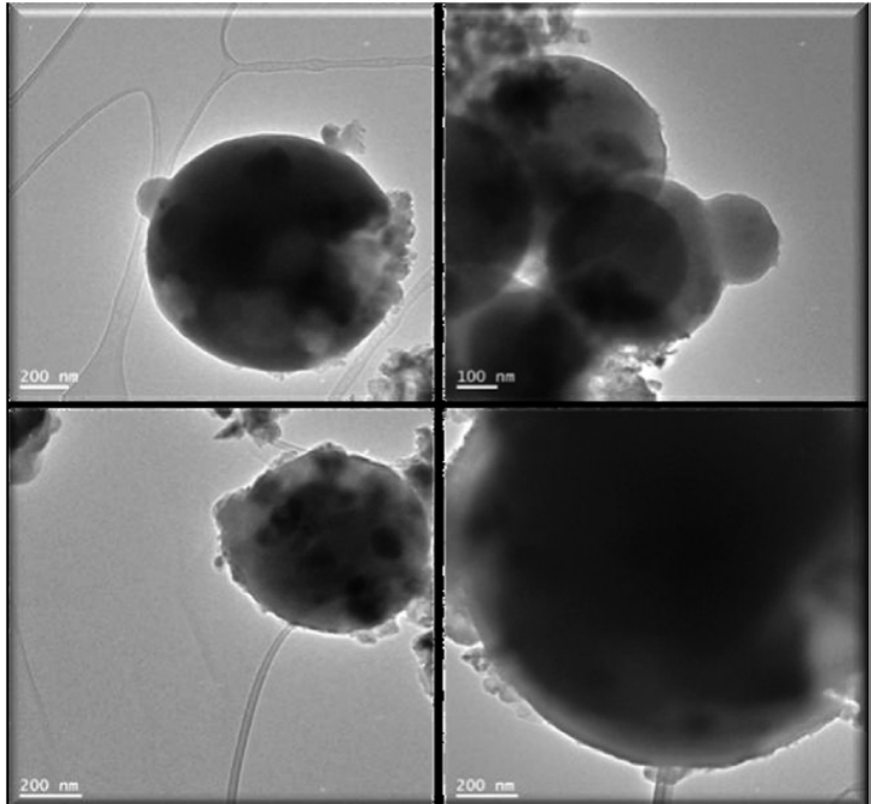
Figure 1: TEM image of NiMoS